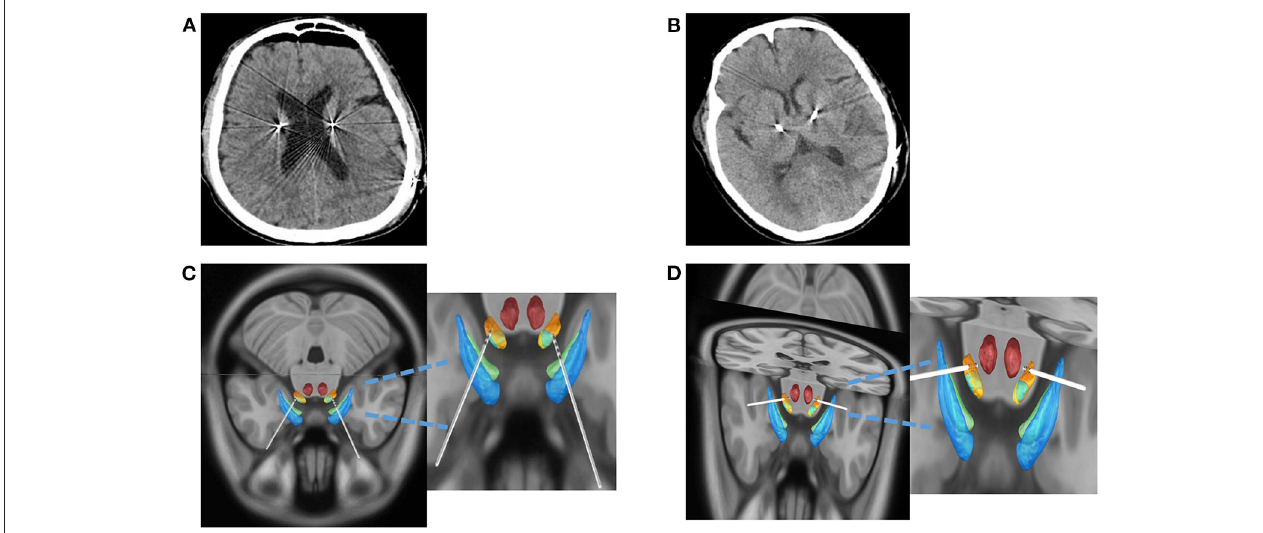
FIGURE 3 | CSF loss and offset of electrode implantation were compared between the two groups. (A) Postoperative CT in DI Group. (B) Postoperative CT in DP Group. (C) The images were reconstructed by the DI group using Lead-DBS software. (D) The images were reconstructed by the DP group using Lead-DBS software. CT, computed tomography; CSF, cerebrospinal fluid; DI, dura incision; DP, dura